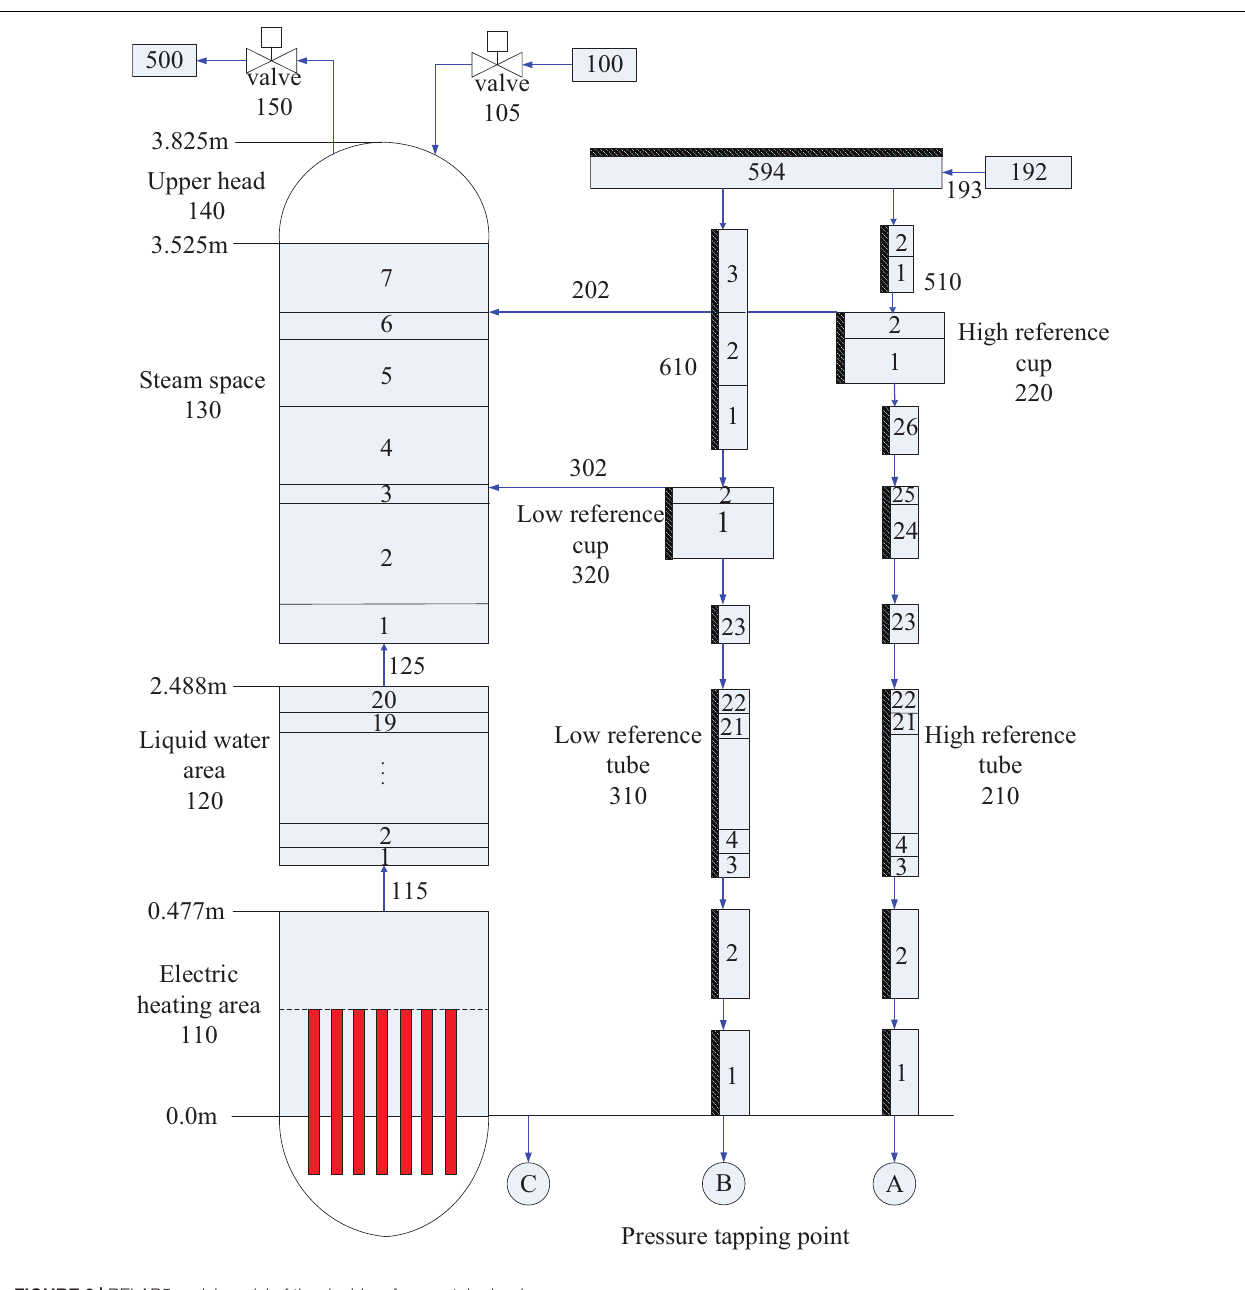
Frontiers in Energy Research |